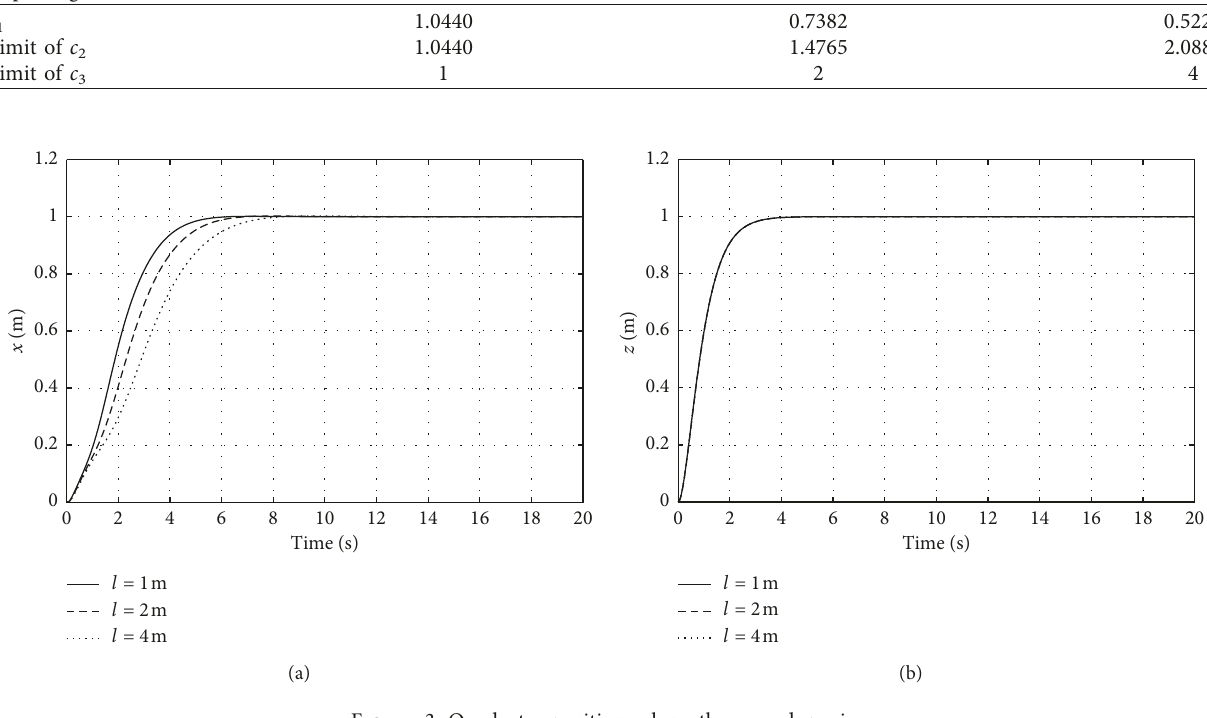
Figure 3: Quadrotor positions along the x - and z -axis.